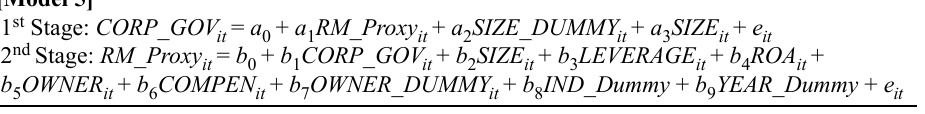
Table 6. Regression of earnings management on corporate governance (2SLS) [Model